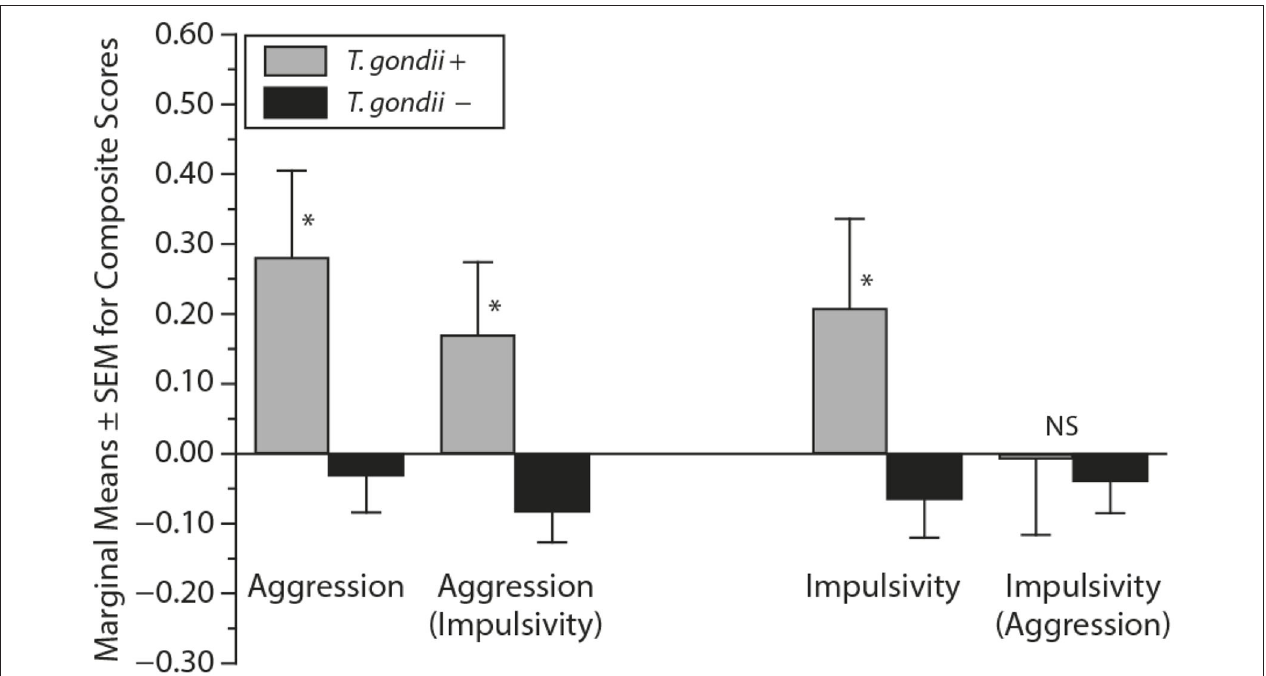
FIGURE 7 | Composite Impulsivity and Aggression (age as covariate) in T. gondii seronegative (–) and seropositive ( + ) participants with history of Intermittent Explosive Disorder. Impulsivity (aggression) refers to Composite Impulsivity scores with Composite Aggression scores as a covariate; aggression (impulsivity) refers to Composite Aggression scores with Composite Impulsivity scores as a covariate. NS, not significant; * p ≤ 0.05. Significantly elevated Aggression and Impulsivity scores in T. gondii positives. Reciprocally adjusting impulsivity and aggression for each other yields a significant association with T. gondii only for Aggression [Reprinted with permission from (117); Copyright 2016, Physicians Postgraduate Press. Reprinted by